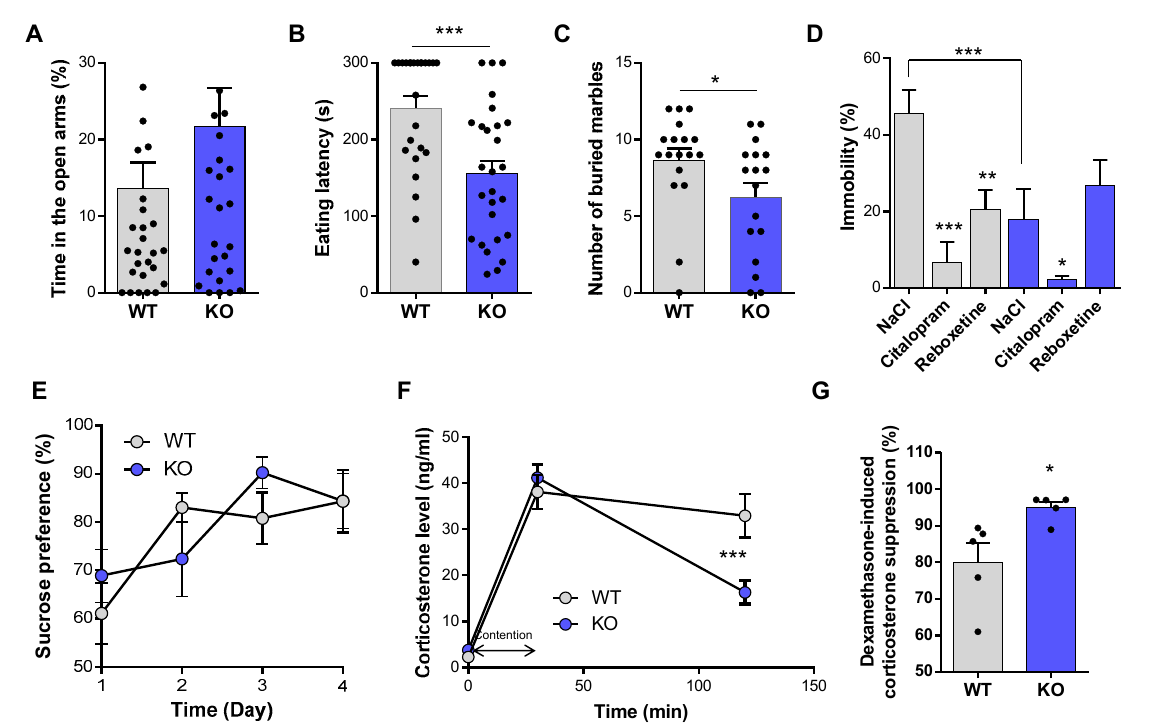
Figure 1. Anxiety and depression-like behavior in VMAT2 DBHcre mice. ( A ) Percentage of time spent in the open arms of the elevated plus maze in VMAT2 DBHcre WT (n = 29) and KO (n = 29) mice (t 56 = − 1.5, p = 0.14, ns ). ( B ). Latency (s) to eat the food pellet placed at the center of the open field in the novelty-suppressed feeding test in VMAT2 DBHcre WT (n = 25) and KO (n = 27) mice (t 50 = 3.70, *** p = 0.0005). ( C ) Number of buried marbles with bedding during 30 min in VMAT2 DBHcre WT (n = 18) and KO (n = 17) mice (t 33 = 2.07, * p = 0.047). ( D ) Percentage of immobility time in the forced swim test in VMAT2 DBHcre WT and KO mice injected intraperitoneally with NaCl (0.9%; WT n = 8, KO n = 8), citalopram (10 mg/kg; WT n = 6, KO n = 8) and reboxetine (20 mg/kg; WT n = 8, KO n = 6; genotype × treatment: F (2,38) = 4.73, p = 0.015; post-hoc test: compared to the NaCl group of the same genotype * p = 0.048 ** p = 0.002 *** p = 0.00004, compared to WT group with the same treatment *** p = 0.0009). ( E ) Percentage of sucrose preference over drinking water during 4 consecutive days in VMAT2 DBHcre WT (n = 10) and KO (n = 9) mice (genotype × day: F (3,48) = 0.81, p = 0.49, ns ). ( F ) Plasma corticosterone level (ng/mL) at baseline, after 30 min of restrain stress and 90 min after the end of the stress in VMAT2 DBHcre WT (n = 18) and KO (n = 17) mice (genotype × time: F (2,66) = 7.63, p = 0.001; post-hoc test : compared to the WT group at the same time *** p = 0.00017). ( G ) Percentage of dexamethasone-induced suppression of plasma corticosterone level in VMAT2 DBHcre WT (n = 5) and KO (n = 5) (t 8 = 2.72, * p = 0.026).